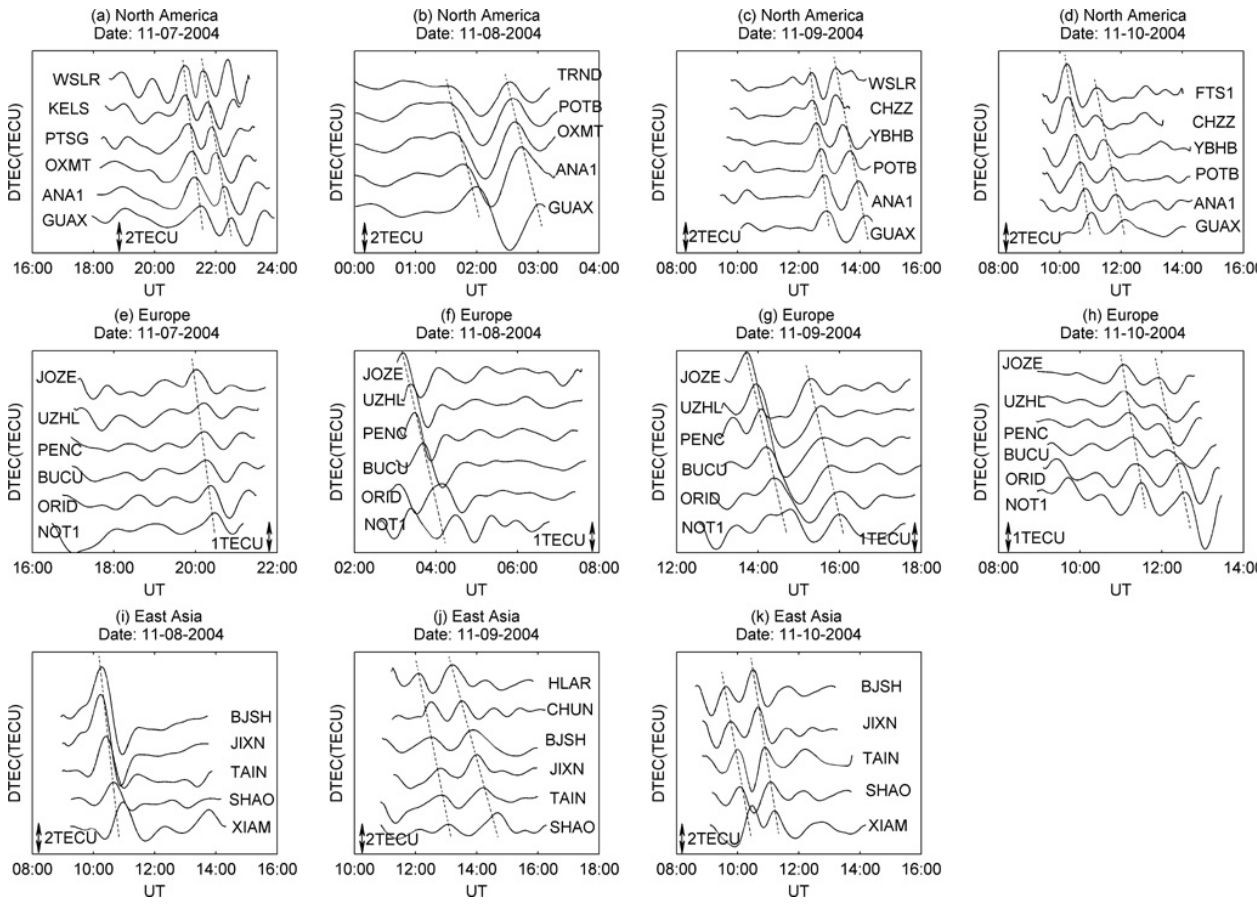
Fig. 3. The time dependence of the deviations of TEC (DTEC) in North America (a) ∼ (d) and in Europe (e) ∼ (h) on 7 ∼ 10 November 2004 and in East Asia (i) ∼ (k) on 8 ∼ 10 November 2004 for TEC data from GPS receivers along longitude of about 120 ◦ W (a) ∼ (d) , 20 ◦ E (e) ∼ (h) and 120 ◦ E (i) ∼ (k) , respectively. The names of the GPS receivers were marked in each of the picture. The phase fronts of the LSTIDs were marked with dash